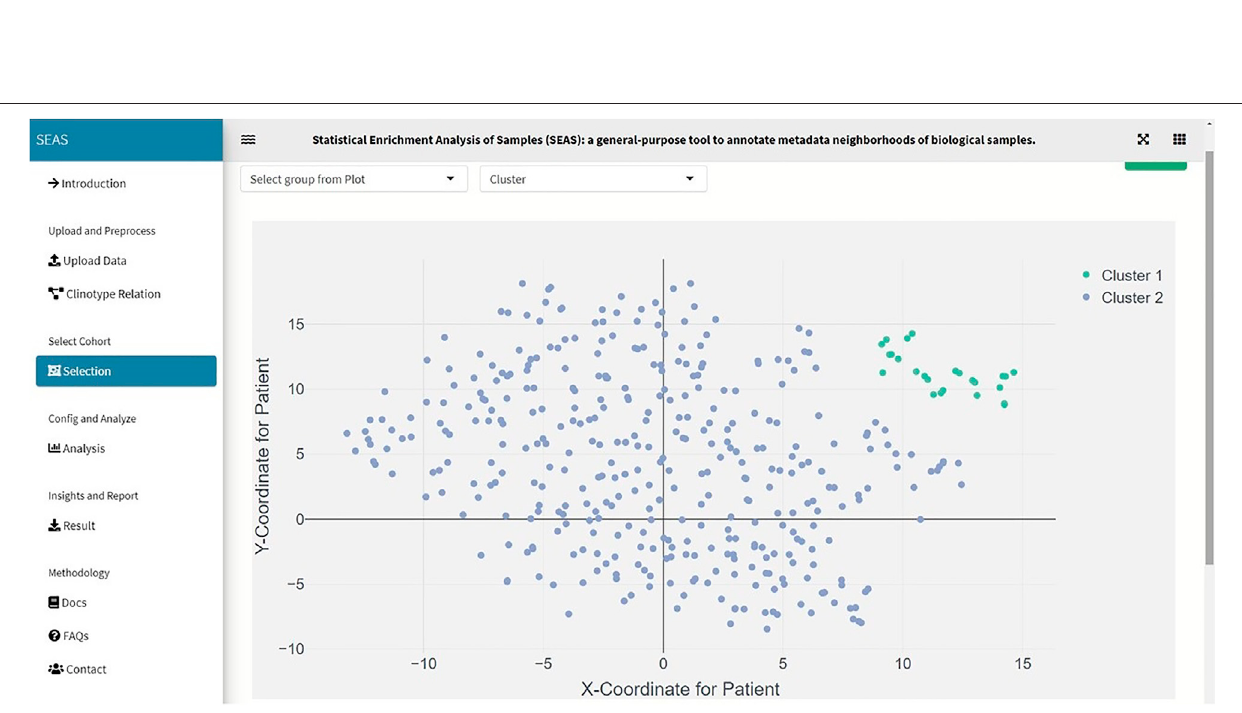
Frontiers in Big Data |